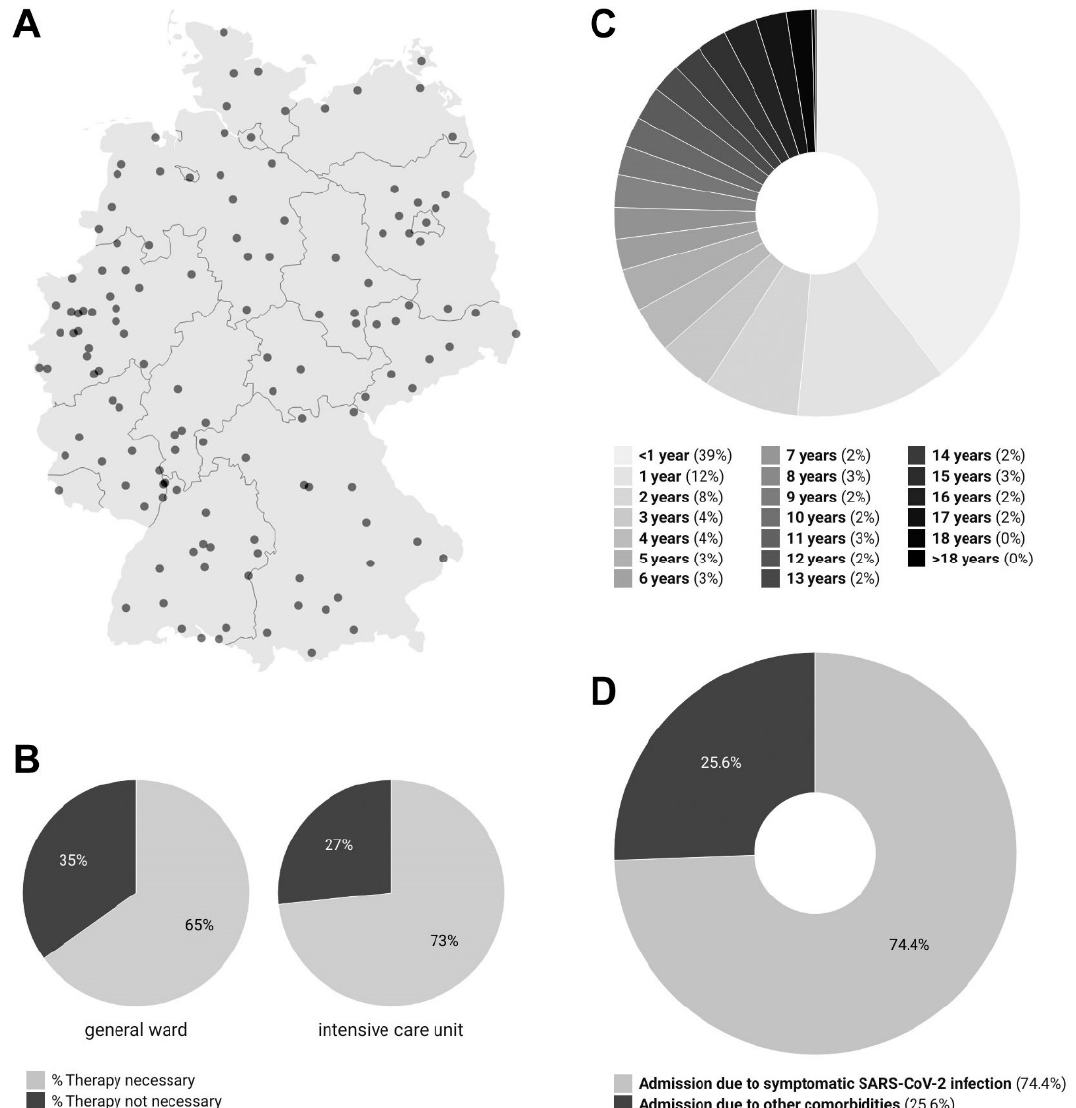
Figure 1. ( A ) German hospitals participating in the SARS-CoV-2 CLRS: Participation rate was inde- pendent of hospital size. ( B ) Need for SARS-CoV-2-specific therapies on general wards vs. intensive care units. ( C ) Age distribution of hospitalized SARS-CoV-2 cases. ( D ) Hospital admission due to symptomatic SARS-CoV-2 infections. * All graphics refer to hospitalized children and adolescents with SARS-CoV-2 in Germany, as reported to the DGPI’s ad hoc SARS-CoV-2 register from 24 January 2022, to 31 July 2022.